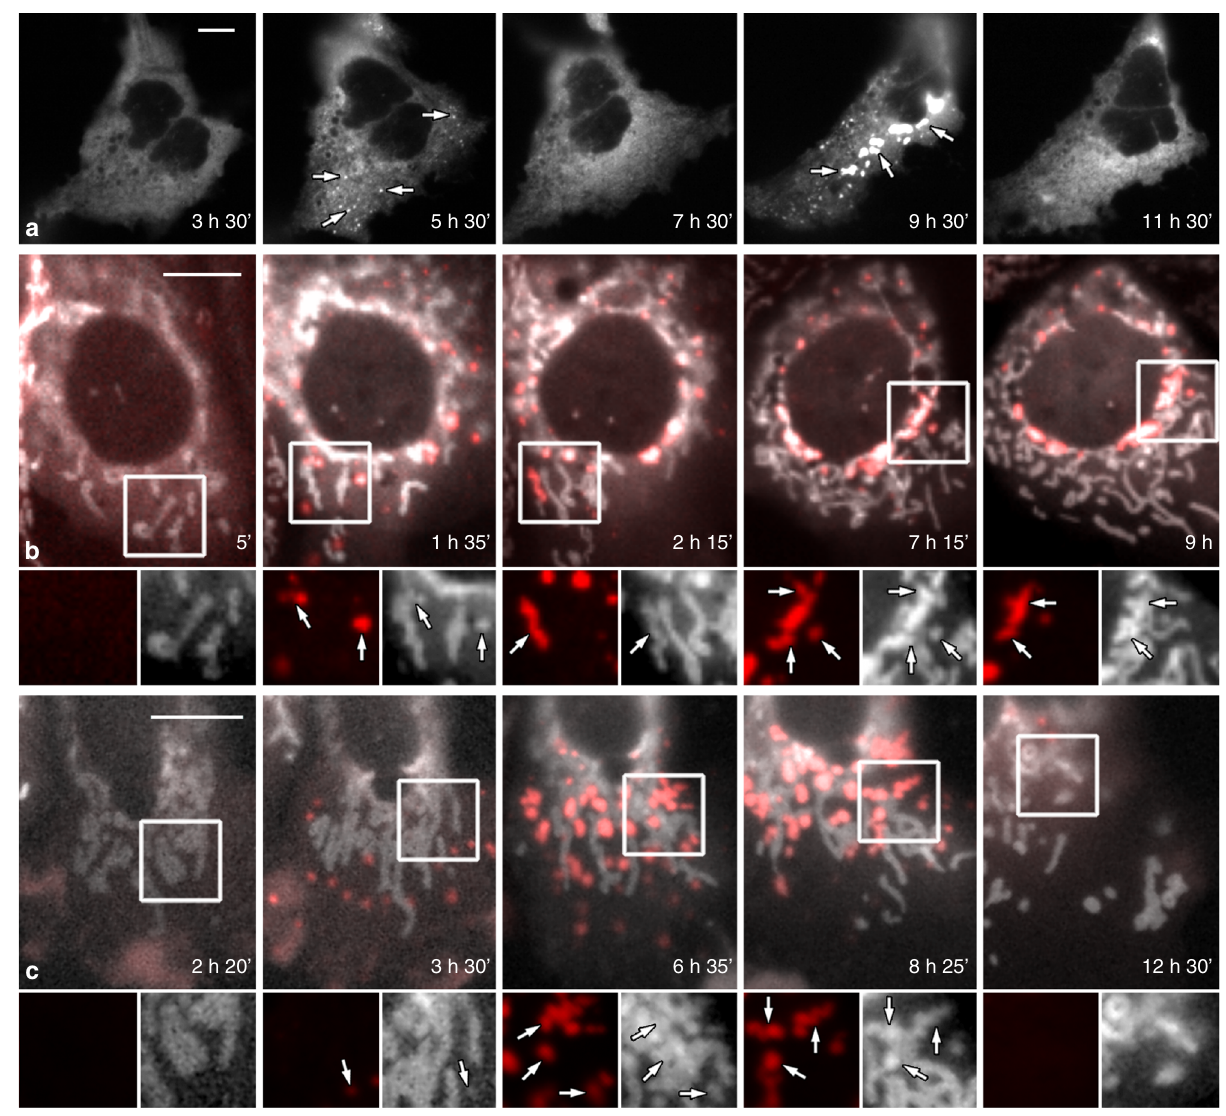
Fig. 2 MxB distribution in living cells is dynamic. a Time-lapse imaging of Hep3B cells expressing mCherry-MxB and viewed over a 16 h time period. Initially, MxB is diffuse in distribution, although condenses into several fi ne puncta by 5 h that subsequently dissolve but reform into much larger structures by 9 h. Surprisingly, these large aggregates also dissolve or disassemble several hours later (see Supplementary Movie 1). b , c Time-lapse imaging of Hep3B cells co-expressing mCherry-MxB (red) and Mito-GFP (white), and viewed over a 16 h time period to test for dynamic associations of MxB with mitochondria. Low-magni fi cation images of cells show the tagged MxB changing from a diffuse to punctate, to diffuse distribution in close proximity of mitochondria. Higher magni fi cation viewing (inserts) reveals that many of these formed puncta associate along or at the tips of the dynamic mitochondria (arrows) (see Supplementary Movies 2 and 3). Scale bars, 10 μ (Fig. 3m – o). As observed in cells expressing exogenous WT or mutant (K131A) MxB protein, these knockdown cells display altered mitochondrial morphologies including fragmented, twisted, or clustered shapes. A comprehensive table showing the effects of MxB knockdown, or overexpression, on mitochondrial shape is provided in Supplementary Fig. 3a. In contrast to the cells overexpressing tagged MxB proteins, the knockdown cells did not exhibit reduced staining for CoxIV or Tom20. EM of siRNA-treated Hep3B cells, however, did reveal highly altered mitochondria with deformed shapes, large vacuoles, and vesiculated cristae (Fig. 3m – o and Supplementary Fig. 2f – h). Based on our fi ndings from the expression of either WT or mutant MxB proteins, and two distinct knockdown strategies, we conclude that this dynamin family member plays an important role in the maintenance of mitochondrial shape and integrity.